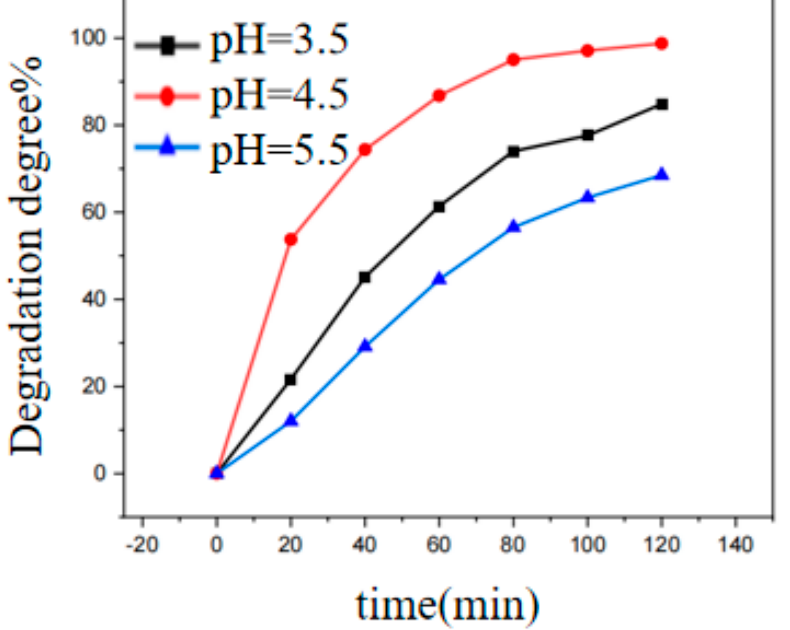
Figure 6. Effects of different pHs on photocatalytic oxidation of RhB. (Reactor: MIL-53(Fe)@CF photocatalytic membrane 150 mg, RhB 1 mg/L, H 2 O 2 1 mmol/L).